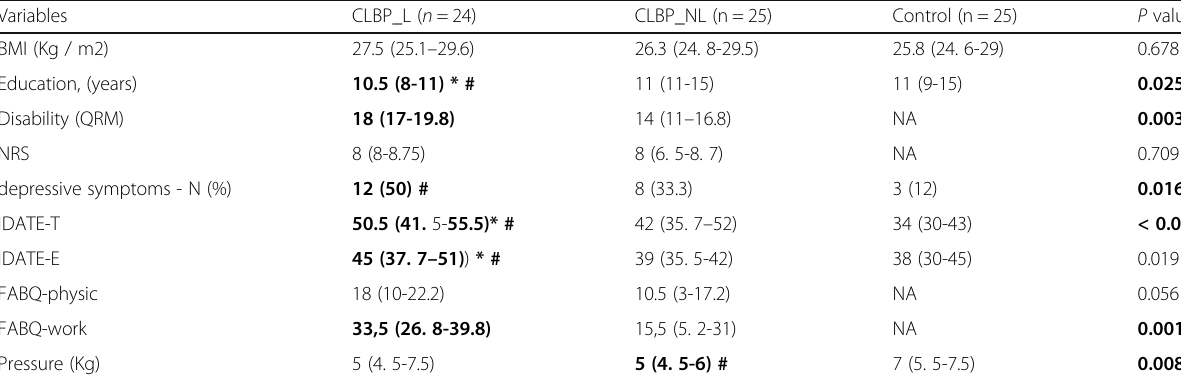
Table 1 Group characteristics and results of pressure pain tests